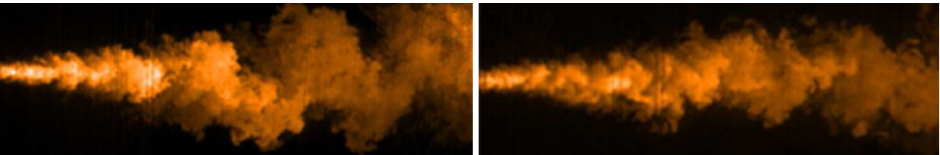
Figure 7. Instantaneous PLIF images of the burner jet in the vertical symmetry plane (for geometry, see Figure 3f), with M sec = 1 to the left and M sec = 5 to the right. Figure adapted from [27]. Reprinted with permission from Springer Nature.